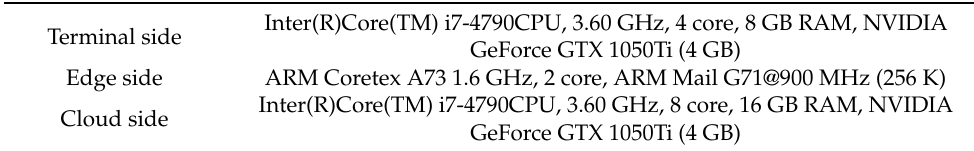
Table 5. The experimental equipment is as